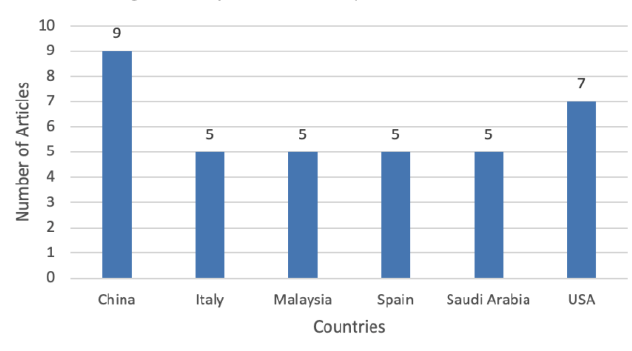
Figure 3: Top 6 countries by research on